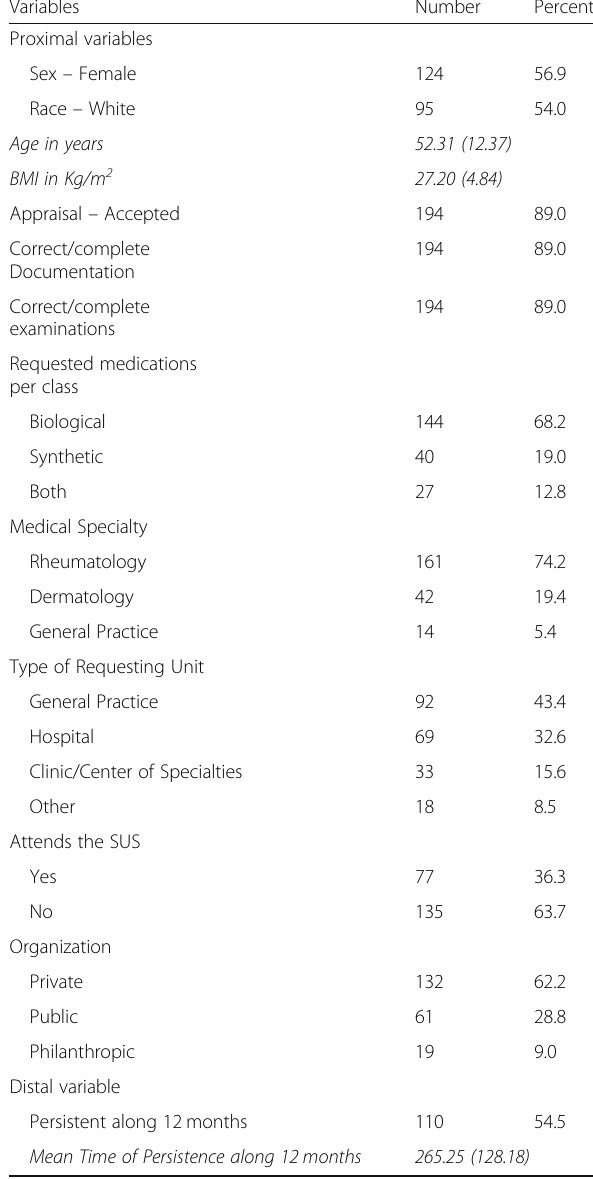
Table 1 Profile of requests of medication for psoriatic arthritis at Belo Horizonte health